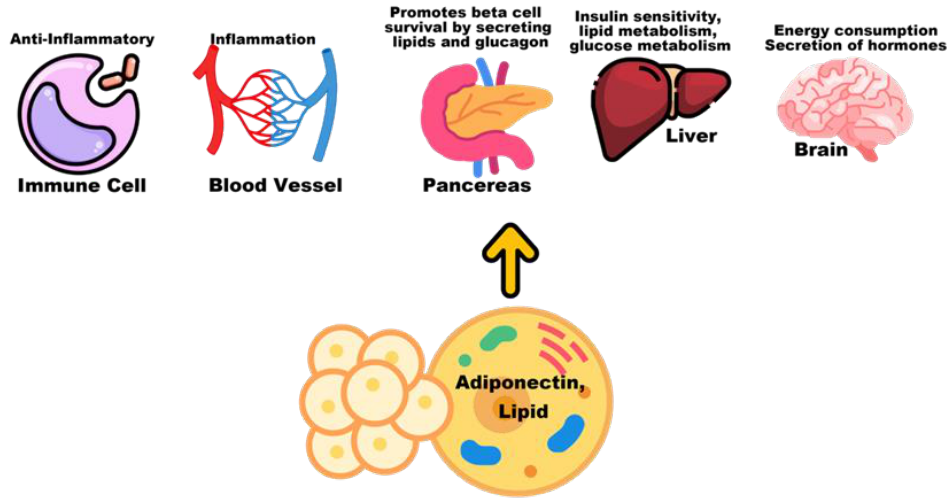
Figure 7. The major processes through which adiponectin maintains metabolic homeostasis.